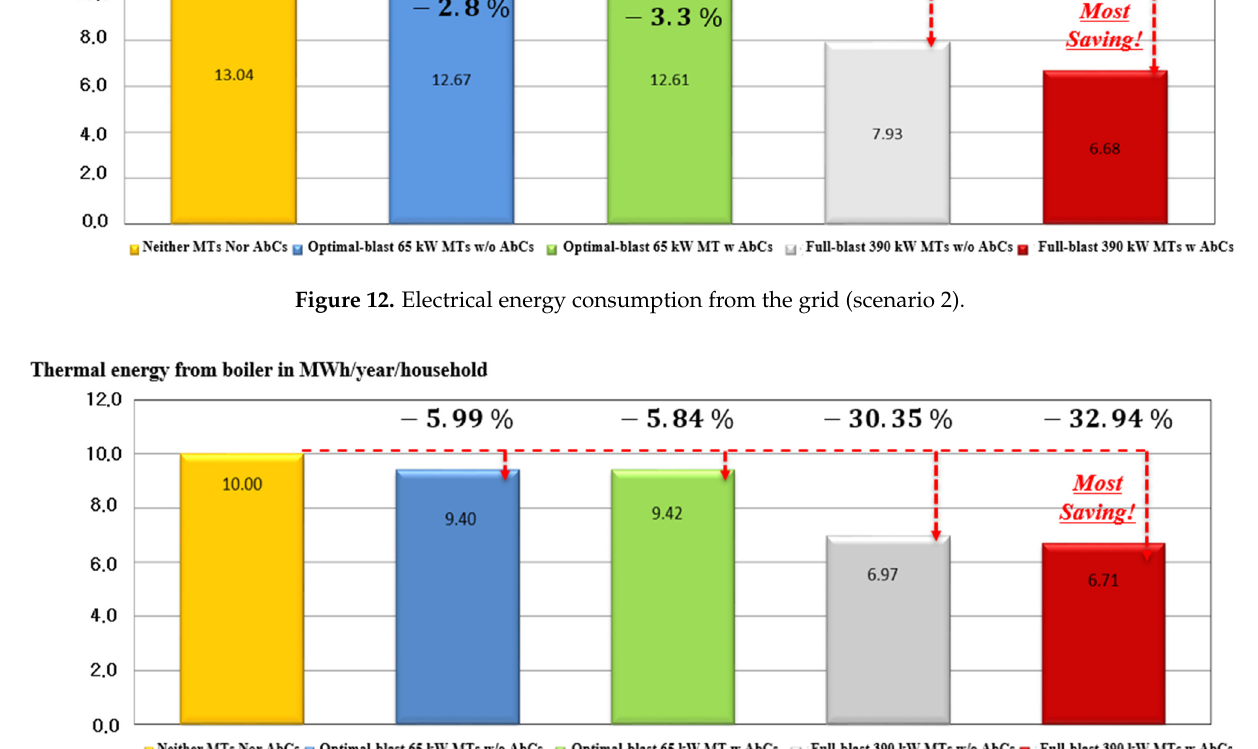
Figure 13. Thermal energy consumption from the boiler (scenario 2).